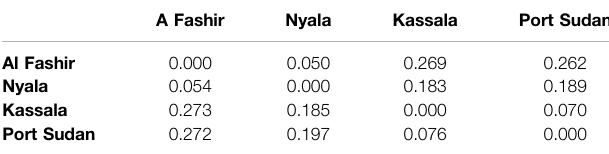
TABLE 3 | Pairwise F STa estimates for Aedes aegypti populations.